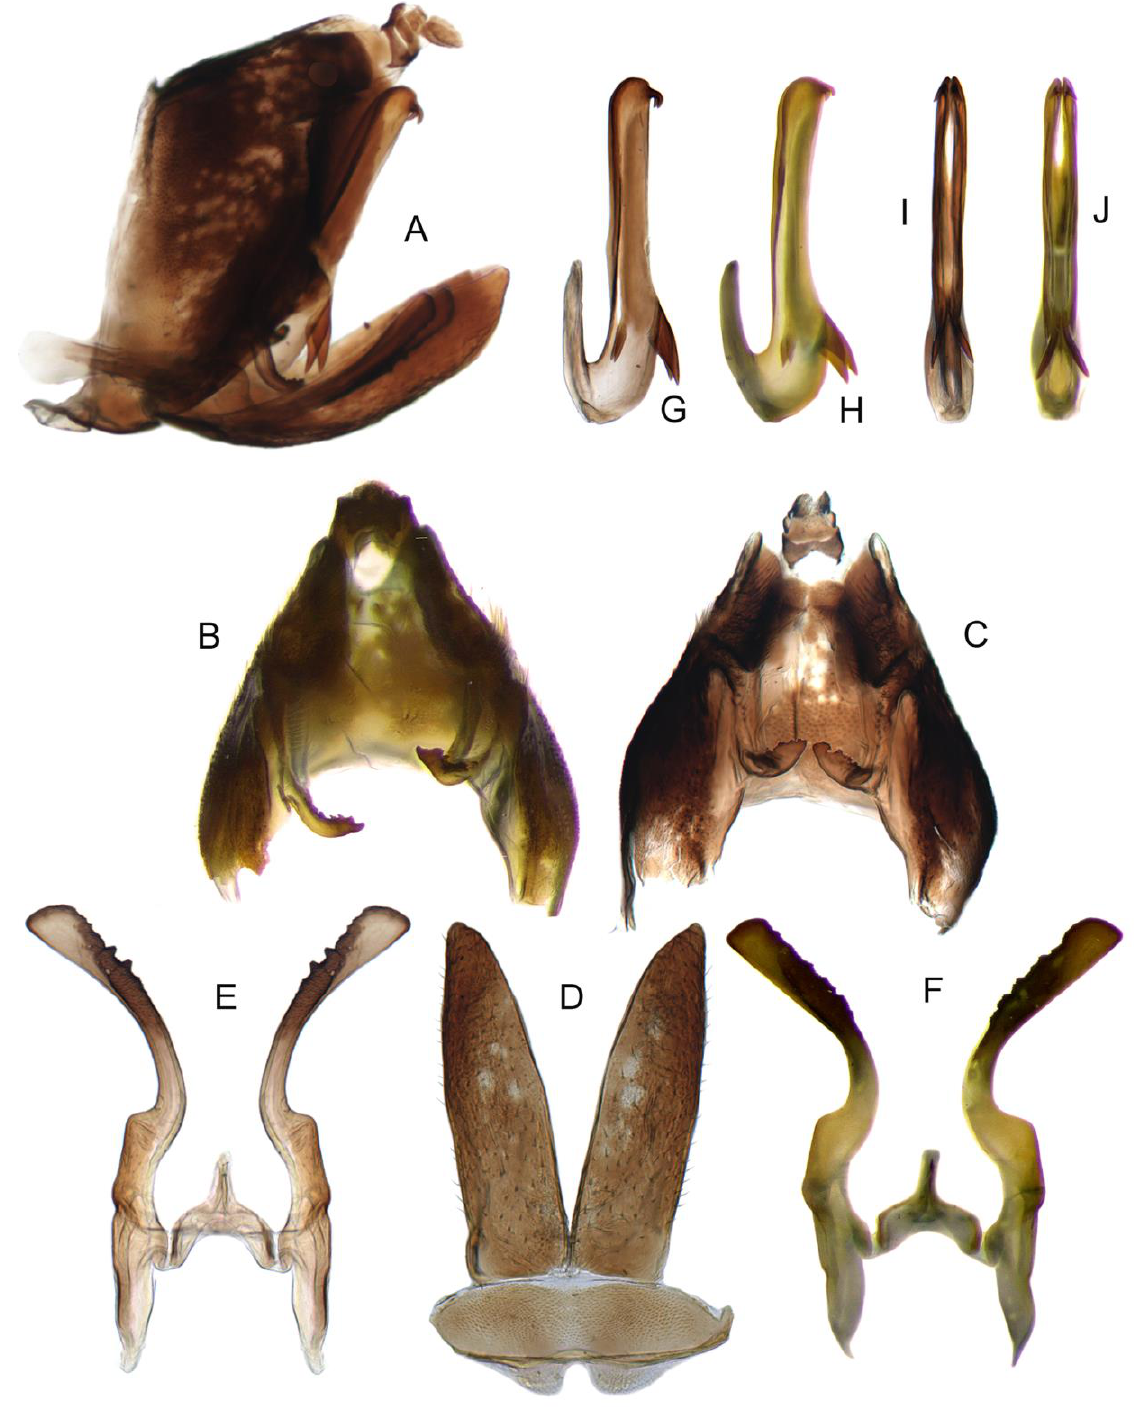
Figure 9. ( A – J ) Planaphrodes sahlbergii . ( A ) pygofer, lateral view. ( B , C ) genital capsule, ventral view. ( D ) subgenital plates, ventral view. ( E , F ) stylets and connective, ventral view. ( G , H ) aedeagus, lateral view. ( I , J ) aedeagus, ventral view ( A – E , G , I ) from China, Jilin; ( B , F , H , J ) from Korea, Seolaksan GW).